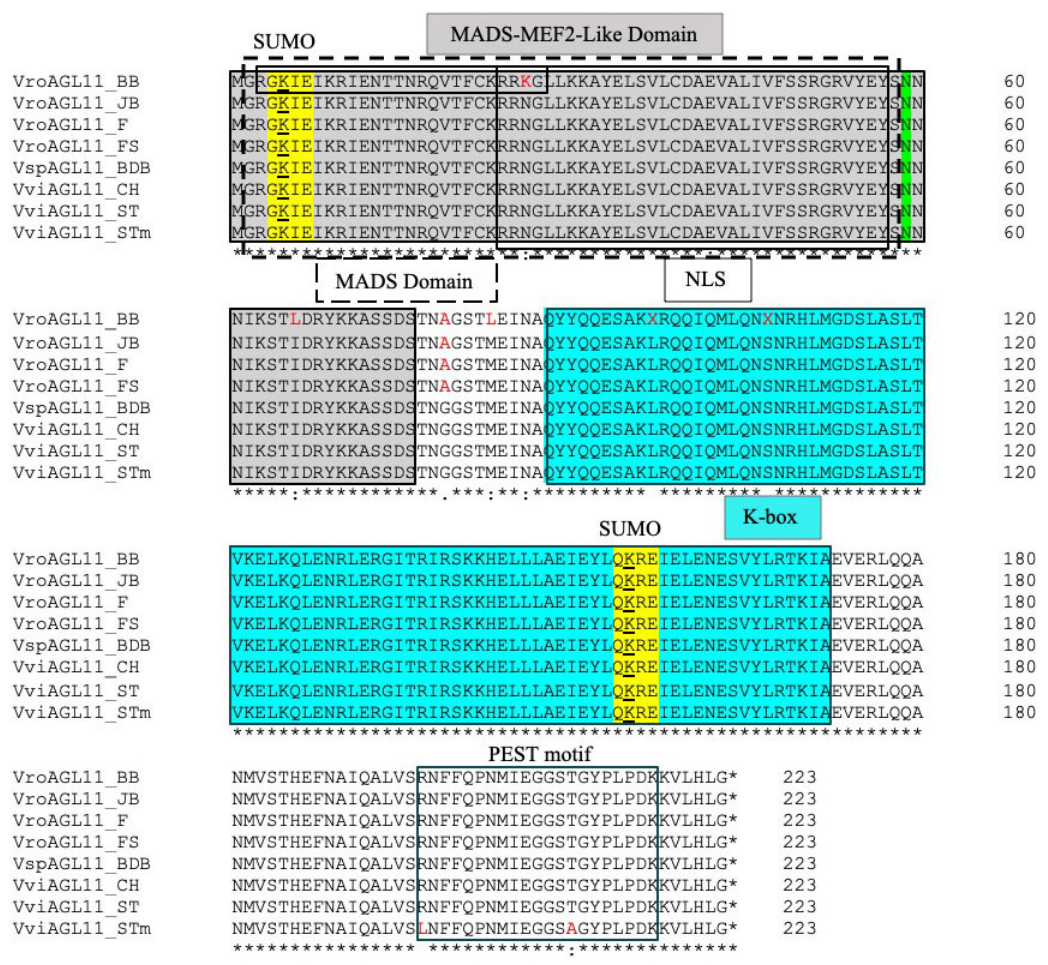
Figure 3. Alignment of the amino acid sequences of all AGL11 proteins of muscadine (cvs. Black Beauty, BB; Jane Bell, JB; Fry, F; Fry Seedless, FS) and hybrid bunch grape (cv. Blanc du Bois, BDB) cultivars with that of published bunch grape cultivars Chardonay (CH: AKJ79177.1) and Sultanina (ST: AKJ79179.1 and mutant allele, STm: AKJ79180.1). Conserved domains, MADS-MEF2-like domain (gray box), MADS domain (dashed line box) and K box (turquoise box), phosphorylation site (N59, highlighted in green), SUMO (sumoylation) and PEST (ubiquitination) motifs, and NLS (nuclear localization signal) sequences are indicated. Red colored amino acids show the amino acid differences between different grape